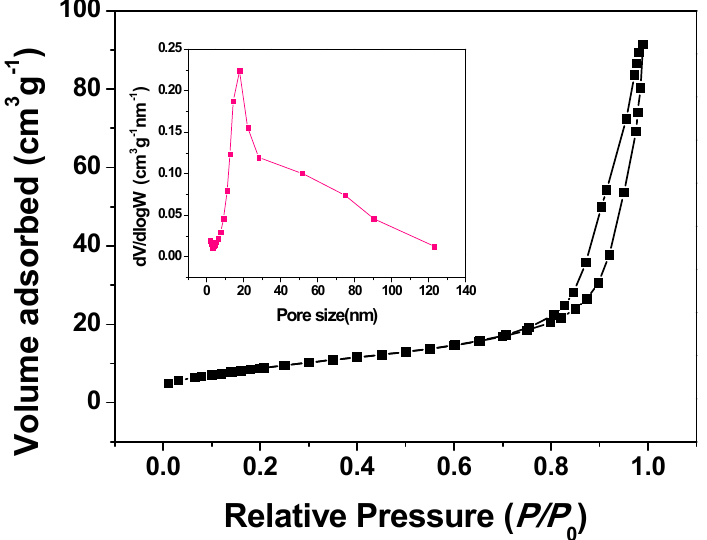
Figure 3. N 2 adsorption-desorption isotherm and Barrett-Joyner-Halenda (BJH) pore size distribution (inset) curve of the as-prepared Co 3 O 4